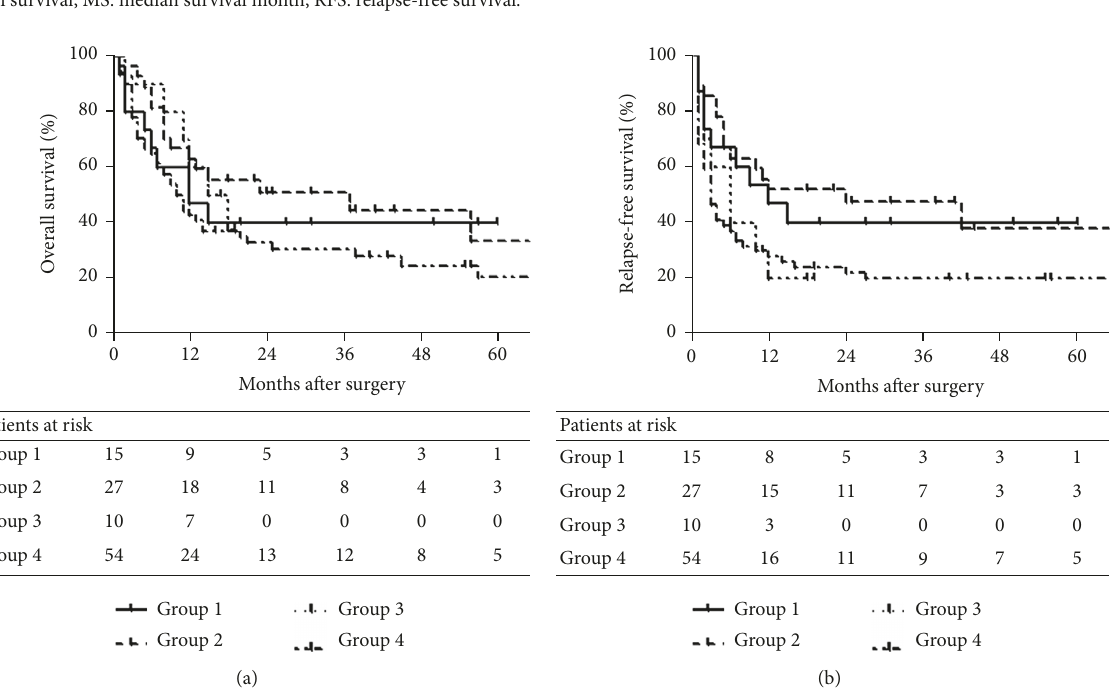
Figure 2: Survival curves of the patients according to the presence of HBV infection and cirrhosis. Shown are the survival curves of the HBV- associated cirrhotic patients (Group 1), HBV-associated noncirrhotic patients (Group 2), HBV-negative cirrhotic patients (Group 3), and HBV-negative noncirrhotic patients (Group 4) on the OS (Panel (a)) and RFS (Panel (b)). The curves demonstrated no significant between- group differences except for Group 2 and Group 4 in the RFS ( 𝑃 = 0.011 ). The most favorable prognosis was found in Group 2 (1-yr OS, 66.7%; 5-yr OS, 16.7%; median survival for OS, 37 months; 1-yr RFS, 55.6%; 5-yr RFS, 16.7%; median survival for RFS, 24 months) and Group 4 showed the worst prognosis (1-yr OS, 44.4%; 5-yr OS, 11.1%; median survival for OS, 10.5 months; 1-yr RFS, 29.6%; 5-yr RFS, 10.4%; median survival for RFS, 3